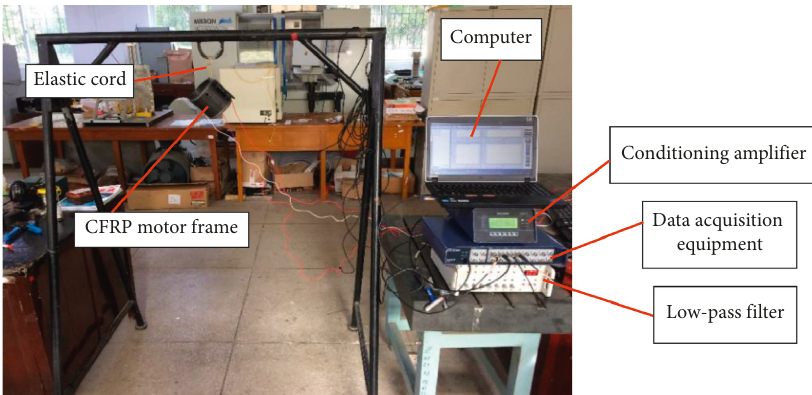
Figure 7: Modal experiment of the CFRP motor frame.